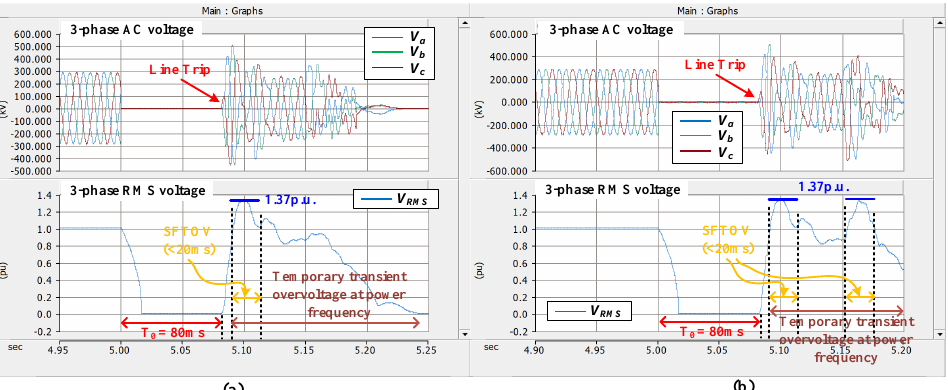
Figure 11. PSCAD/EMTDC simulation results according to AC filter mechanical switch open time delay. ( a ) No time delay and ( b ) 60